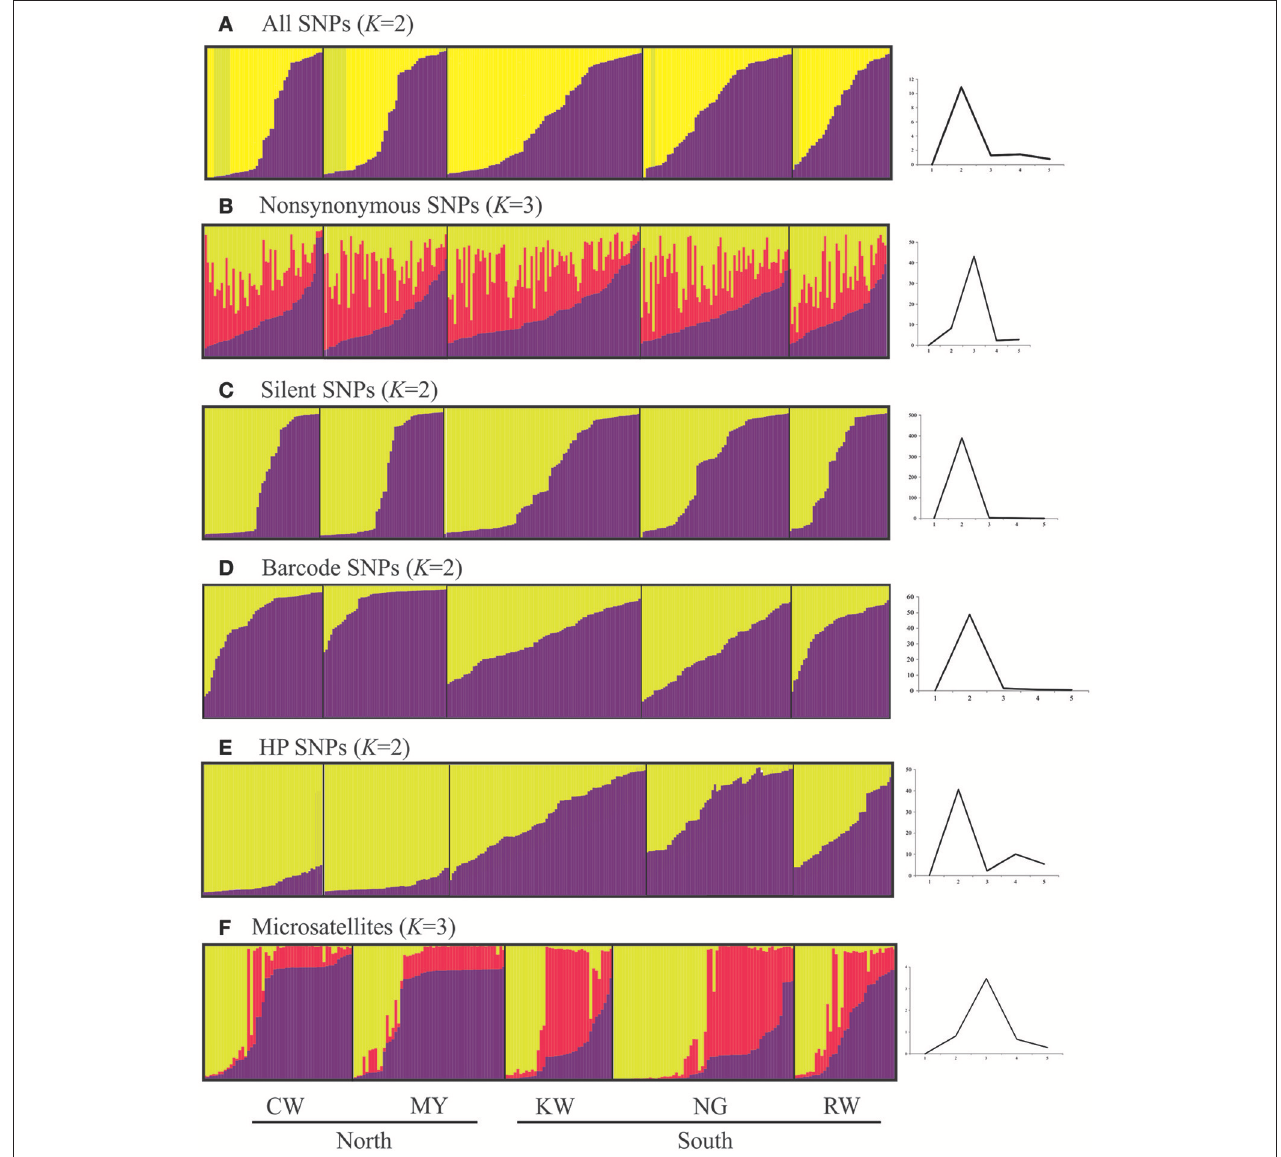
FIGURE 7 | Histograms based on Structure analyses showing partitioning of samples to the defined genetic clusters based on the different types and SNPs and microsatellites. Each defined cluster is represented by a different color. The number of K clusters (plots on the right) was determined by the posterior probability of likelihood values obtained in the Bayesian run, which were used to detect the modal value of 1 K , a quantity related to the second-order rate of change with respect to K of the likelihood